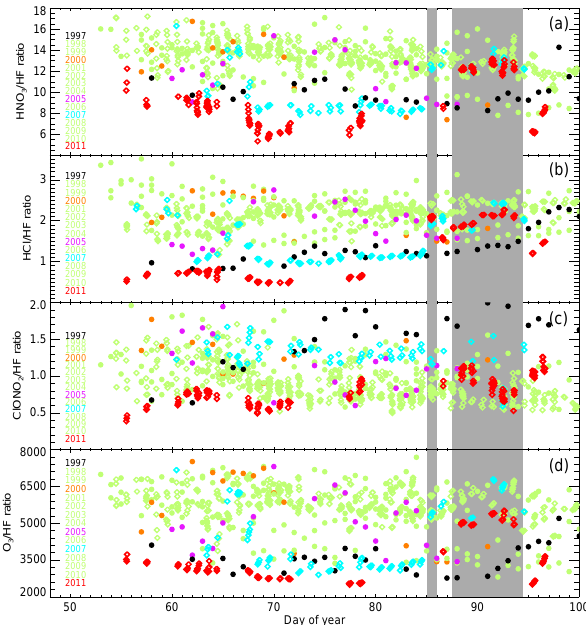
Fig. 6. Spring time series of (a) HNO 3 , (b) HCl, (c) ClONO 2 , and (d) ozone, normalized by HF total columns, from 1997 to 2011. Filled circles represent DA8 ratios and open diamonds represent 125HR ratios. The colors correspond to different years as shown in the legend. The gray shading has the same meaning as in Fig.